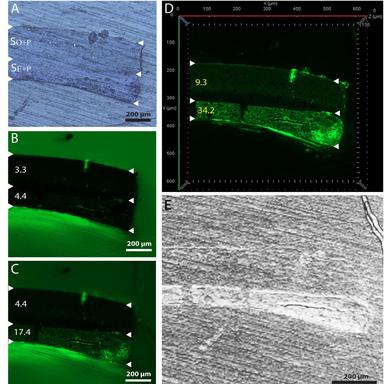
Cross section images of the blue coloured micro (model) sample, containing the pigment prussian blue, photographed prior to antibody hybridisation using the reflected-light brightfield observation (texp 2.7 ms; frame A) and the widefield fluorescence observation (texp 1700 ms, frame B) modes. After antibody hybridisation, the sample was again captured in the widefield fluorescence observation mode under the same illumination conditions (frame C) and was laser scanned using confocal fluorescence microscopy (